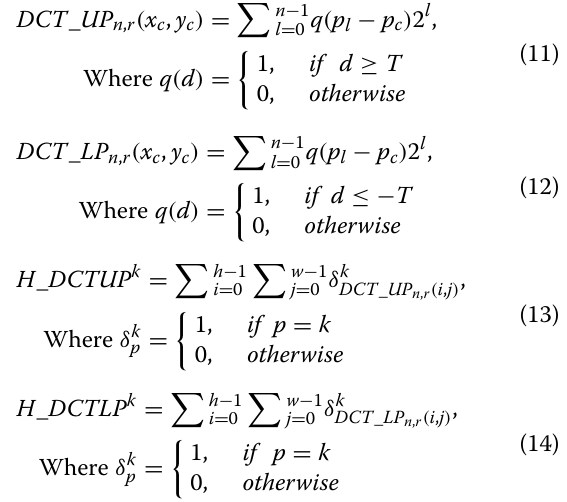
4.2 Discriminative ternary census transform histogram